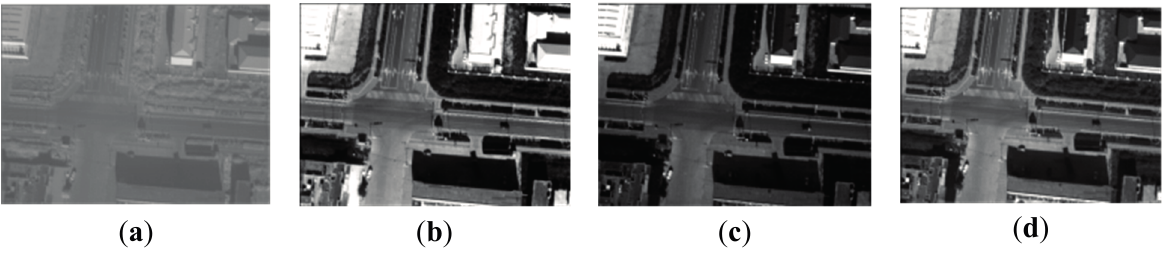
Figure 4. The band images; ( a ) the infrared band; ( b ) the red band; ( c ) the green band; ( d ) the blue band.